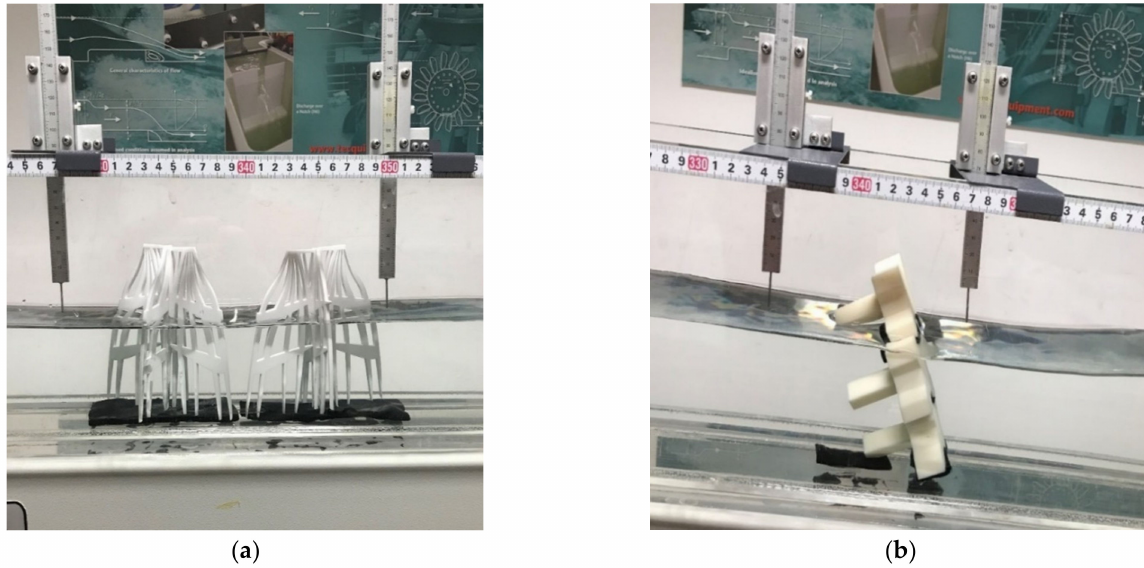
Figure 3. Front view showing before and after model wave height measurements using the pin-tipped steel ruler for two mangrove roots ( a ) and one Xbloc wall ( b ) (three Xblocs on top of each other = Xbloc wall).